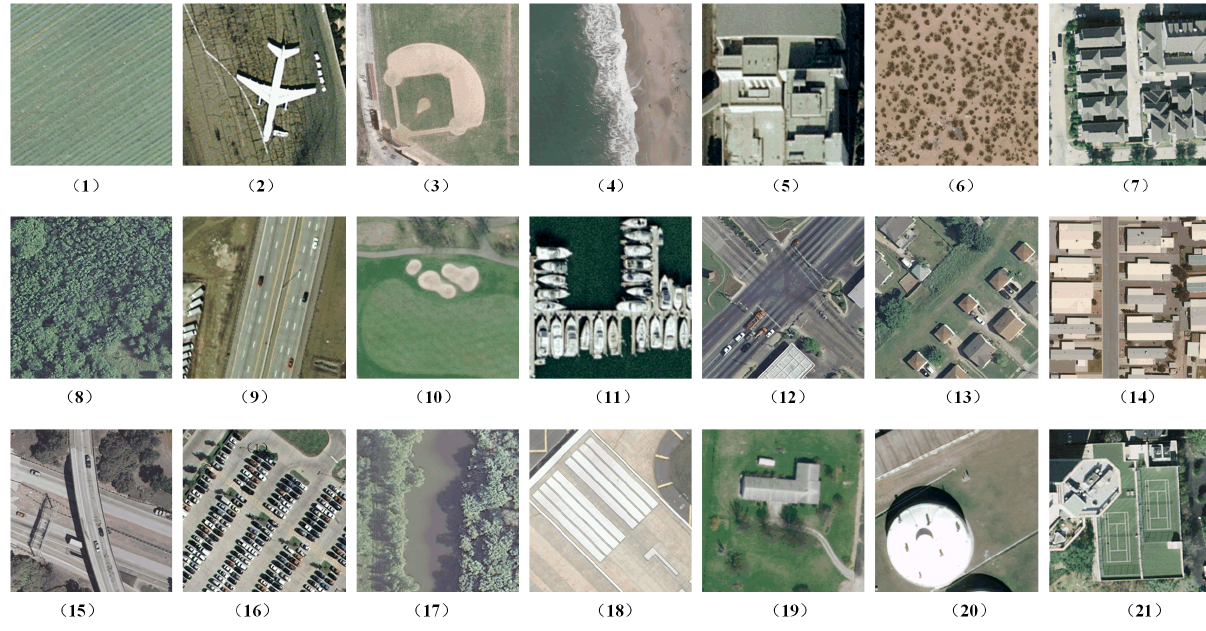
Figure 5. Example images from the UCM dataset: (1) agricultural; (2) airplane; (3) baseball diamond; (4) beach; (5) building; (6) chaparral; (7) dense residential; (8) forest; (9) freeway; (10) golfcourse; (11) harbor; (12) intersection; (13) medium residential; (14) mobile home park; (15) overpass; (16) parking lot; (17) river; (18) runway; (19) sparse residential; (20) storage tank; (21) tennis